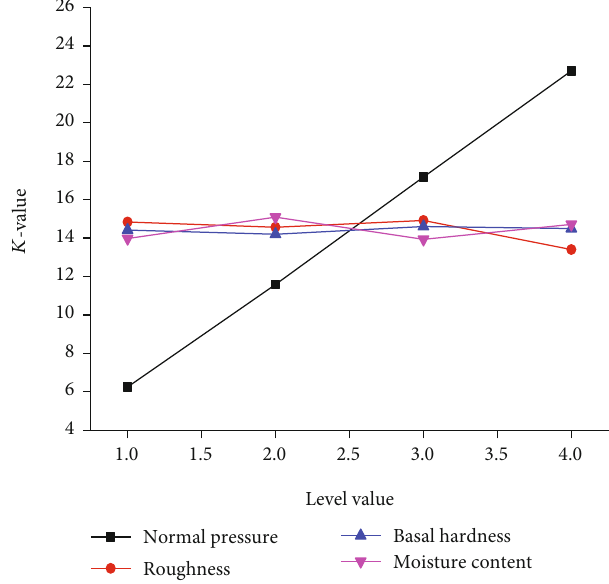
Figure 9: Relationship between shear strength and in fl uencing